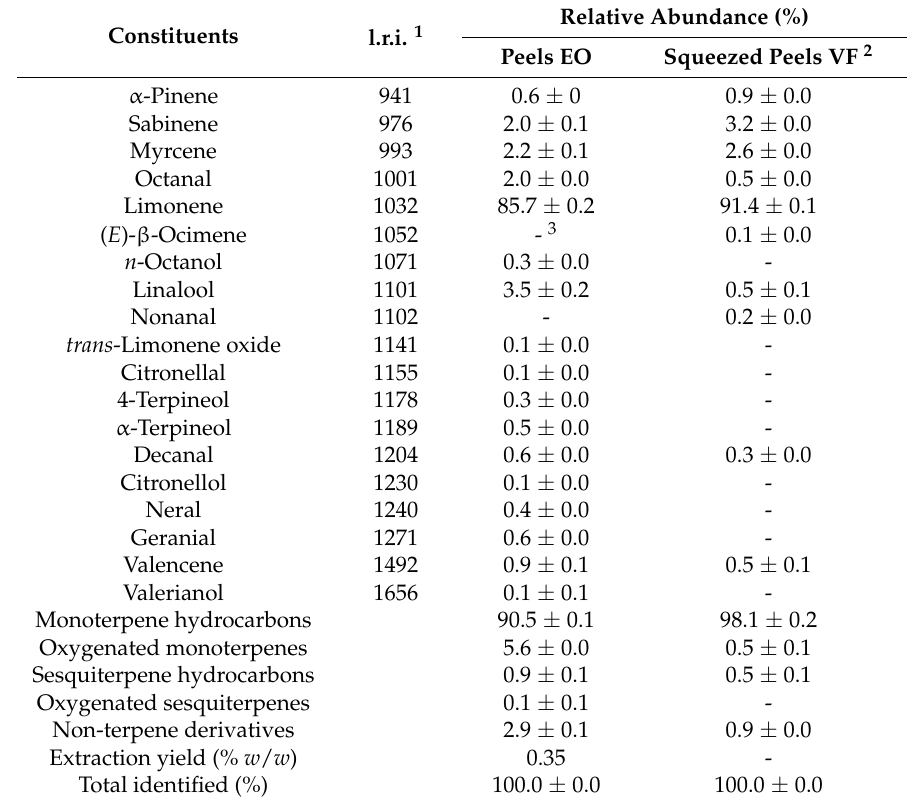
Table 2. Complete compositions of the essential oils of the peels of the orange ( Citrus sinensis (L.) Osbeck), both manually squeezed and